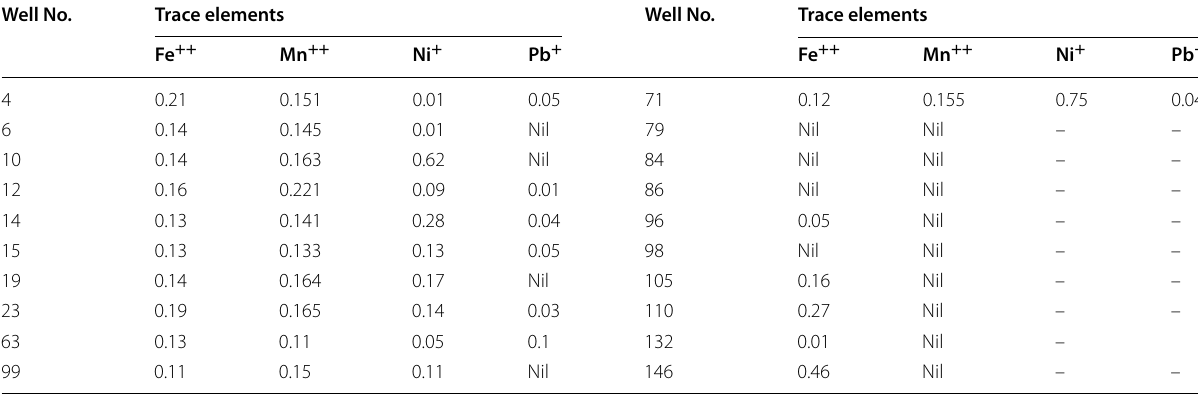
types. Plotting groundwater samples on the Sulin diagram (Fig. 10) indicates that most of the samples are of meteoric origin (Na 2 SO 4 and NaHCO 3 ), while other samples could be of a mixed origin with deeper groundwater sources such as the Nubian water (Himida 1970).